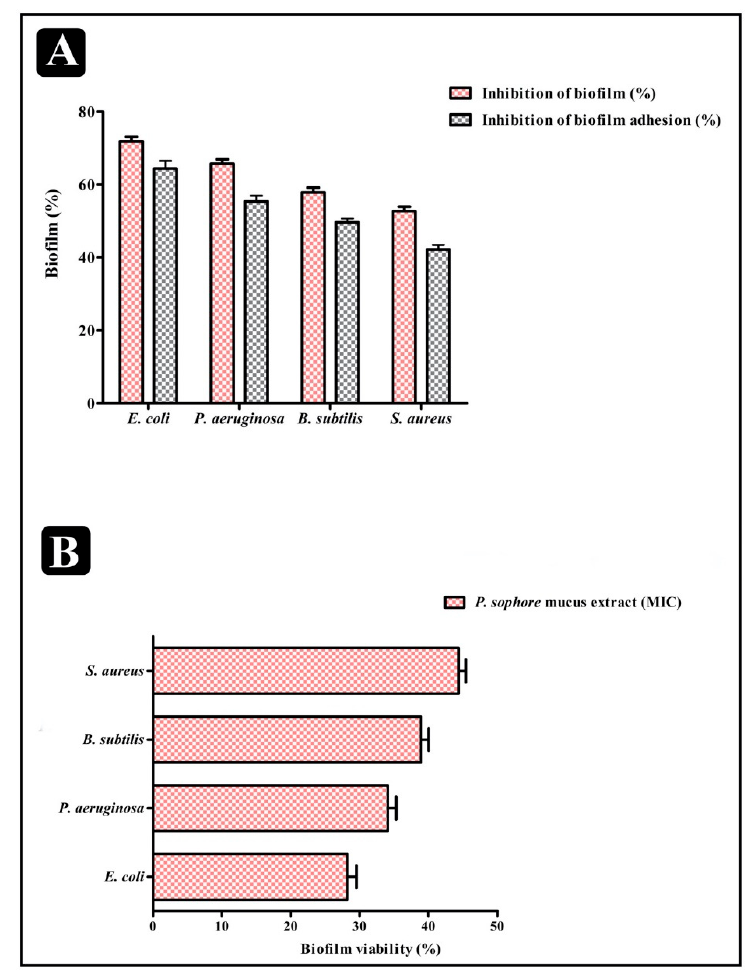
Figure 4. Antibiofilm potential of P. sophore mucus extract and XTT reduction assay. ( A ) Effect of P. sophore mucus extraction established biofilms and on adherence ability of E. coli , P. aeruginosa , B. subtilis , and S. aureus at their respective MICs. ( B ) Percentage of bacterial viability within biofilms measured by the XTT assay at respective MICs. All experiments were carried out in triplicate, and data represent the mean ± standard error of mean